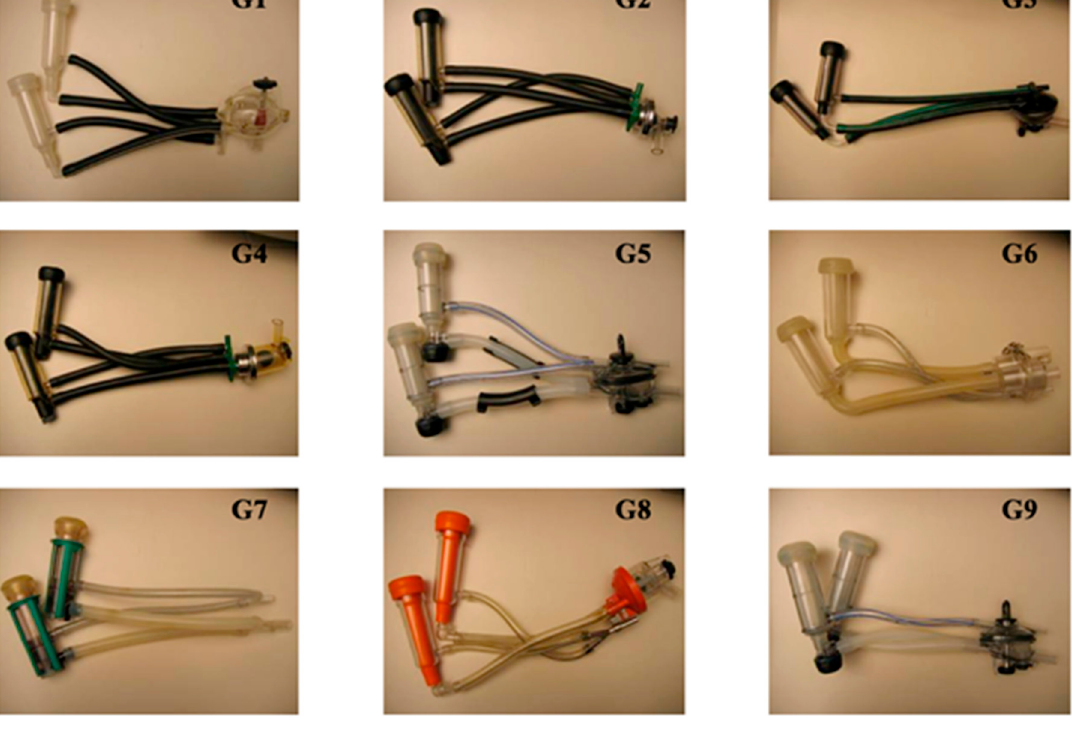
Table 1. Main characteristics and dimensions of the milking units adopted in the research trials.